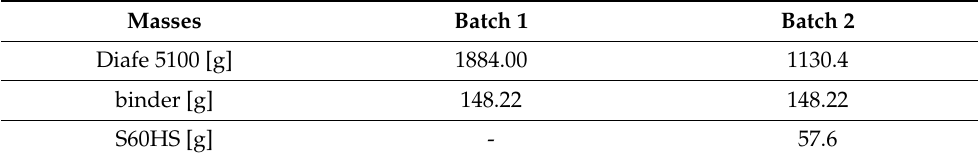
Table 2. Composition of mixtures of the test batches.